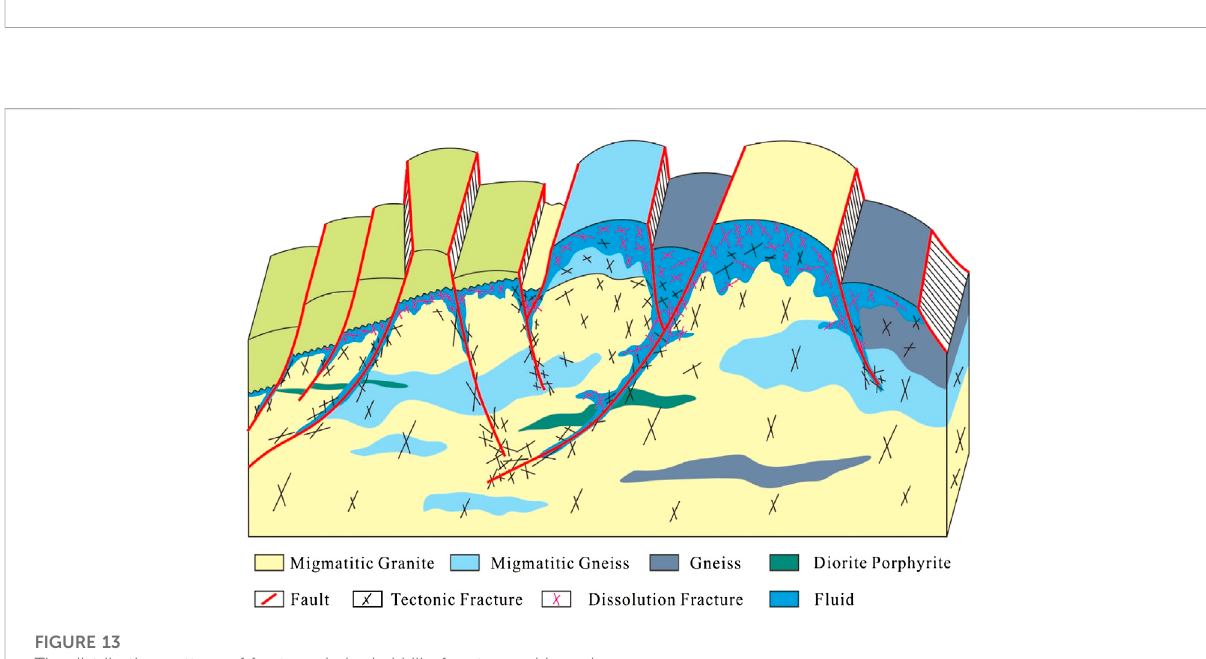
FIGURE 13 The distribution pattern of fractures in buried hill of metamorphic